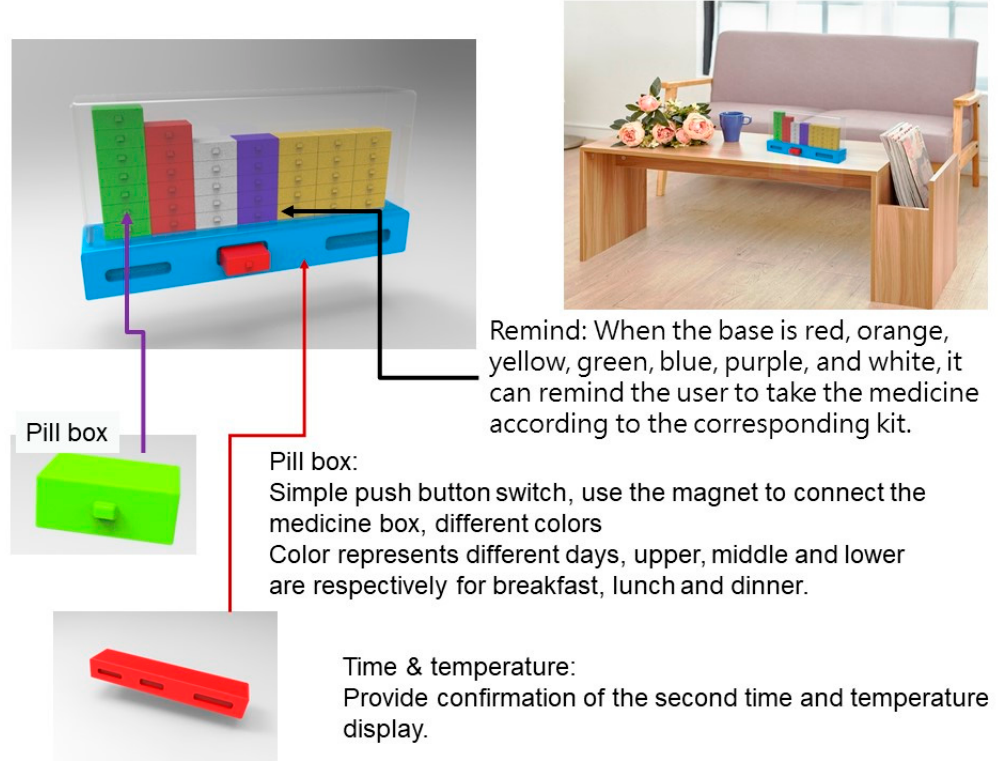
Figure 4. Pillbox control module mock-up.